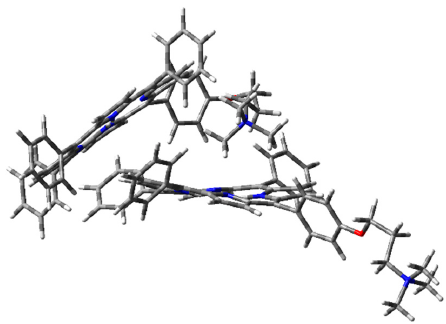
Figure 11. 1H 2 cation– π dimer geometry optimization in the vacuum (PCM) with WB97XD functional and 6-31G(d) basis set.